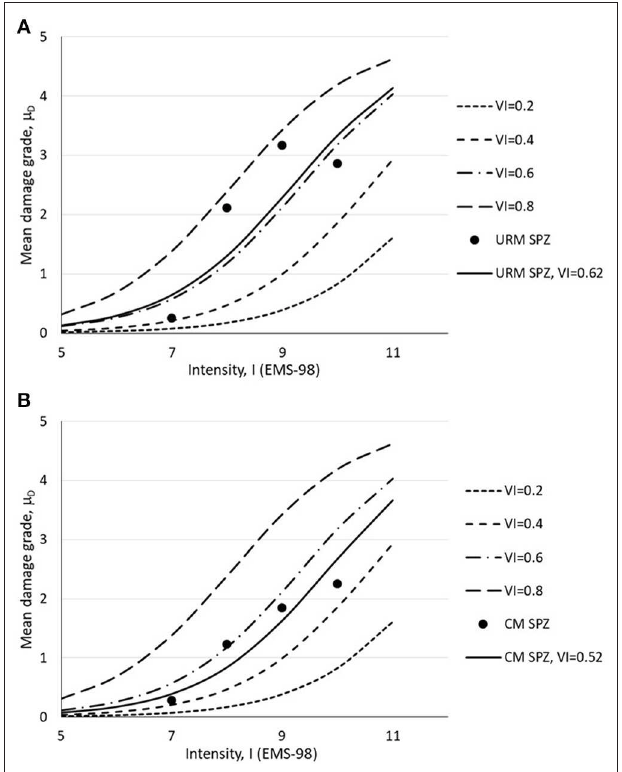
FIGURE 6 | Mean damage grade as a function of intensity from damage survey detected for (A) URM buildings and (B) CM buildings under the Sarpol-e-zahab earthquake (original).